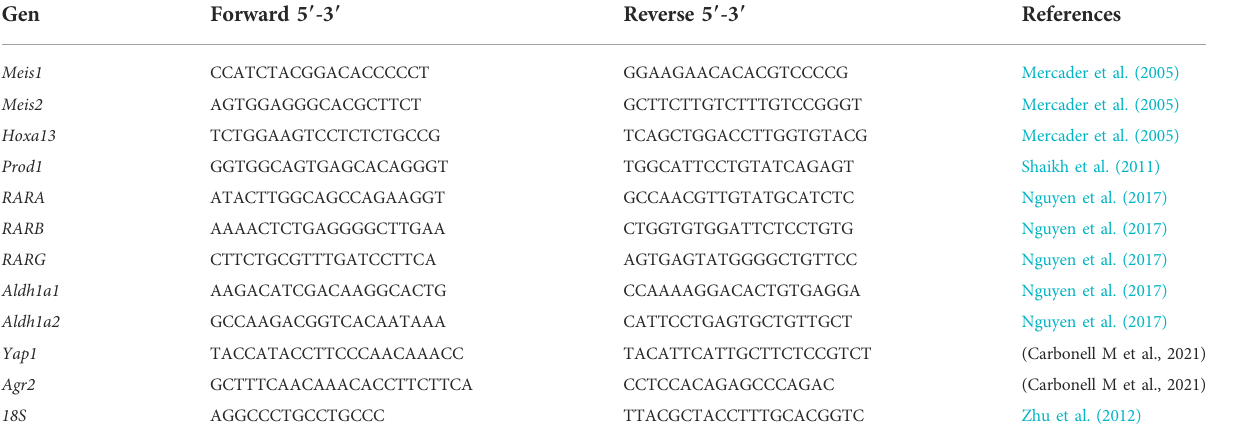
TABLE 1 List of primers used for